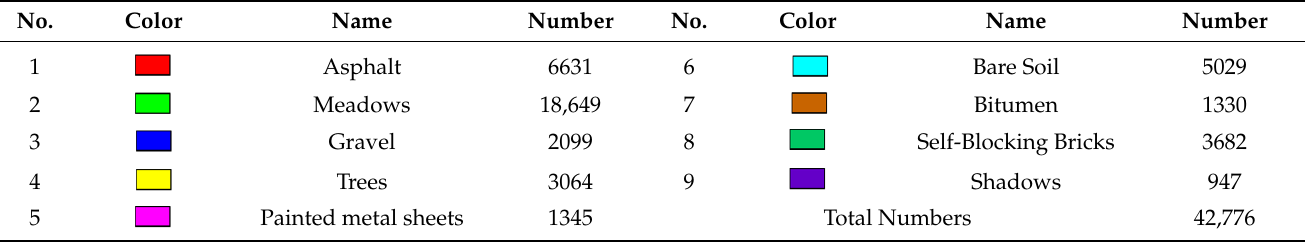
Table 3. Land cover types and total number of samples in the Salinas dataset.